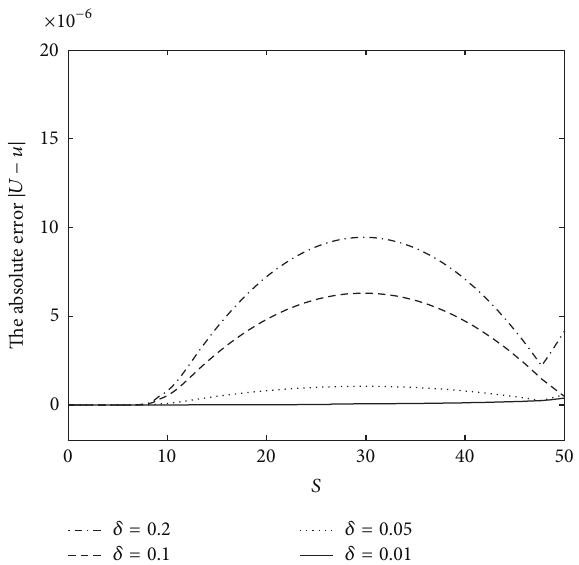
Figure 2: The associated error for several values of 𝛿 .